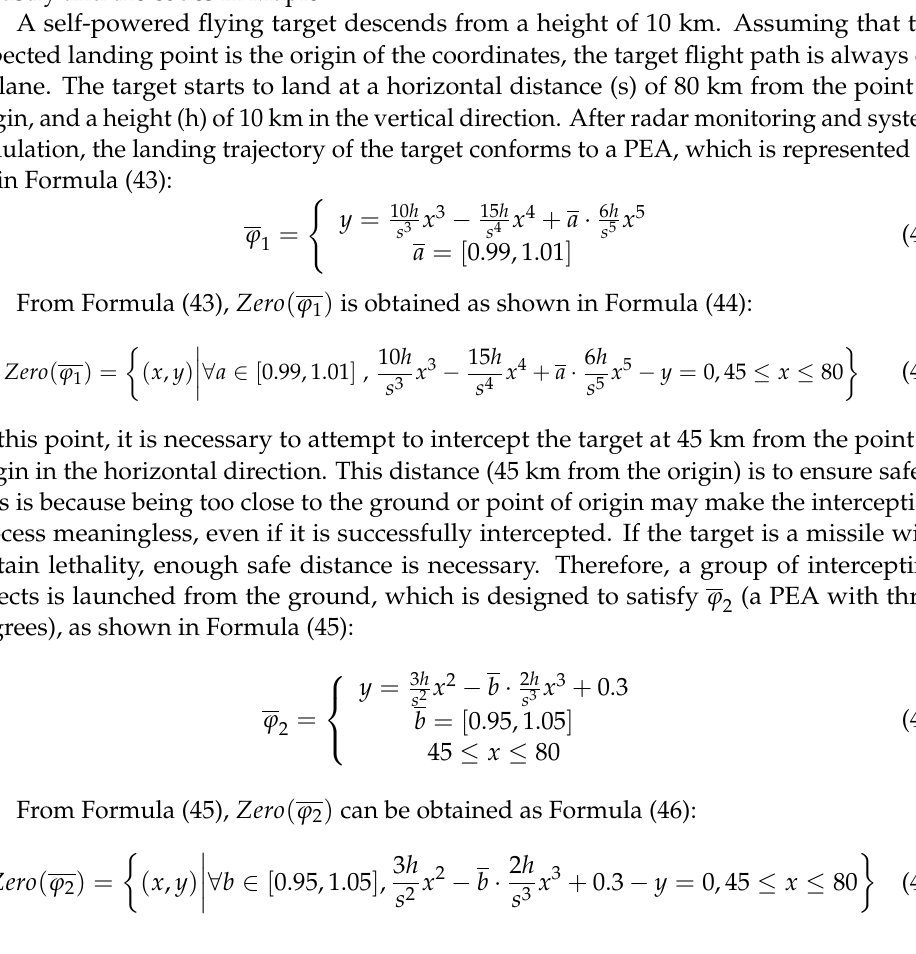
Figure 6. The situation regarding a = 5.